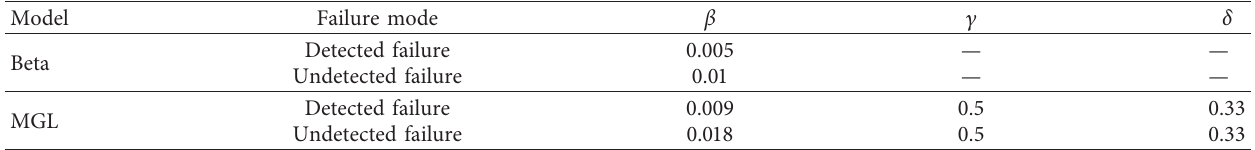
Table 2: Parameters of CCFs models.